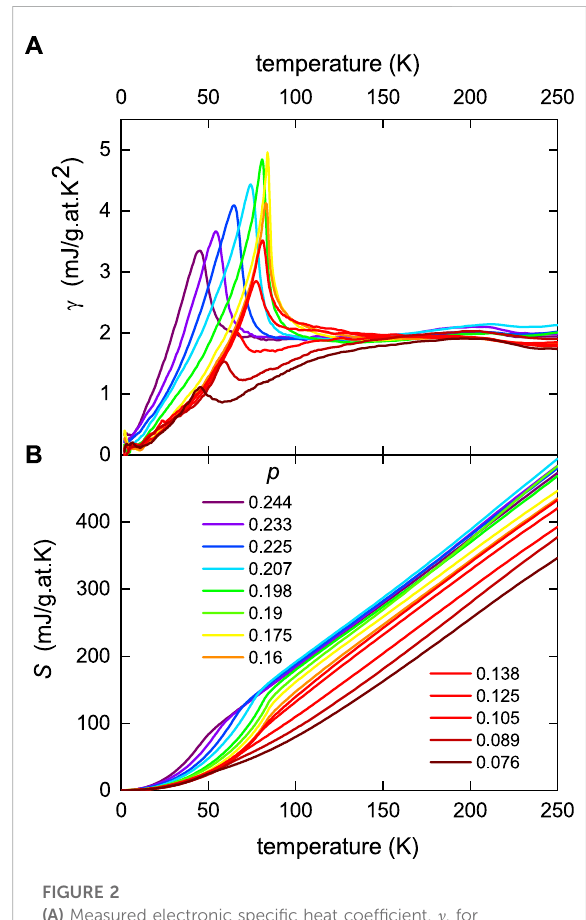
FIGURE 2 (A) Measured electronic speci fi c heat coef fi cient, γ , for Y 0.8 Ca 0.2 Ba 2 Cu 3 O 7 − δ reported by Loram et al. [11]; and (B) the electronic entropy calculated from γ in (A) by integration. The doping states span from under-doped p ≈ 0.07 to over- doped p ≈ 0.23 in small steps of approximately